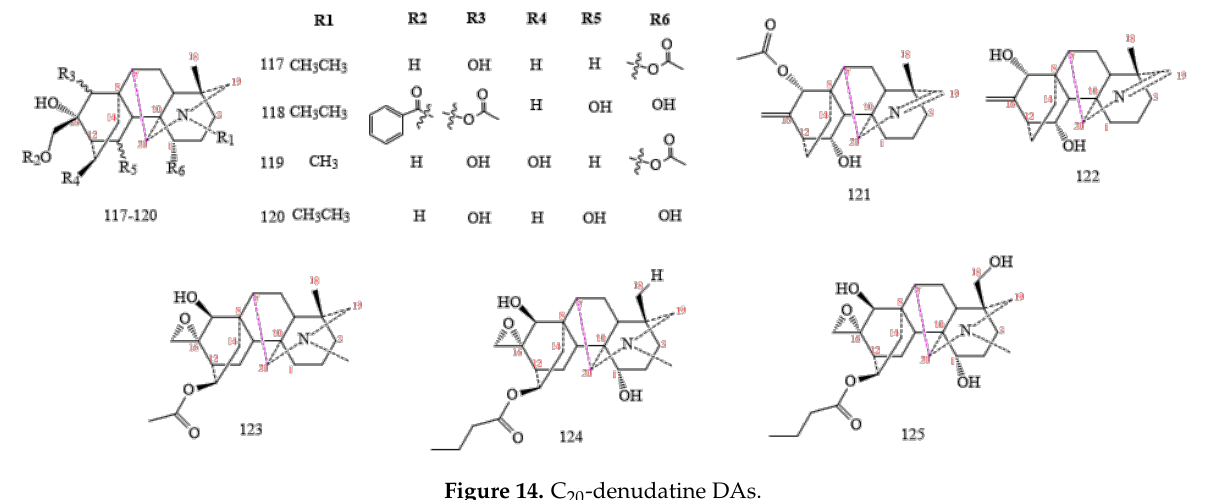
Figure 14. C 20 -denudatine DAs.